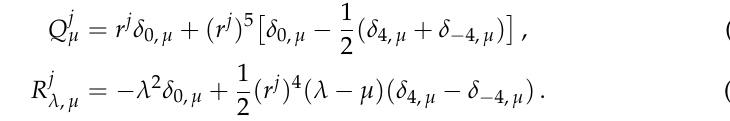
} . We used , − π , − π , − π 6 2 12 4